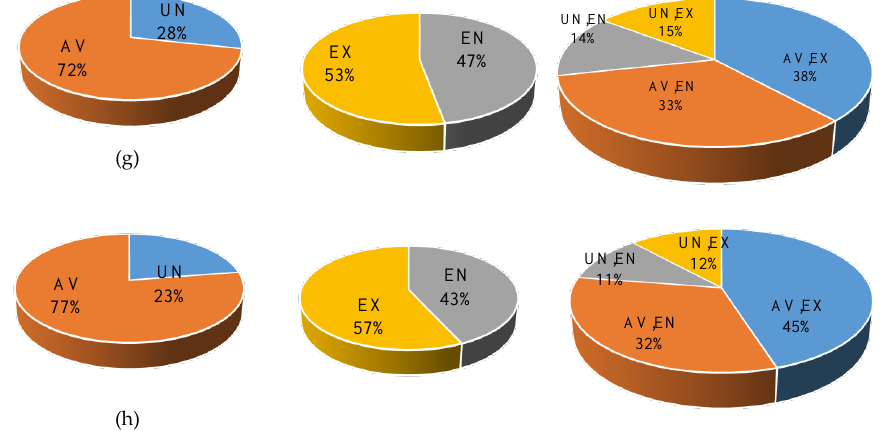
Figure 6. Splitting exergy destruction rates of components: ( a ) the evaporator, ( b ) turbine, ( c ) pump1, ( d ) pump2, ( e ) pump3, ( f ) feed-water heater1, ( g ) feed-water heater 2 and ( h ) condenser in the DRORC system.